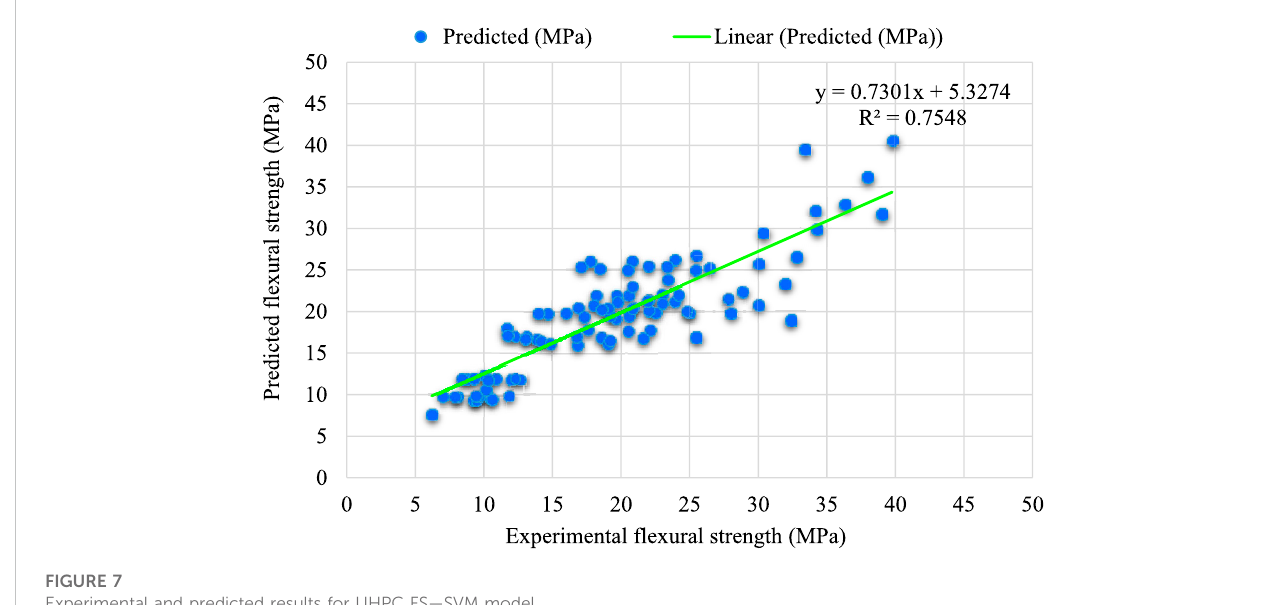
FIGURE 7 Experimental and predicted results for UHPC FS — SVM model.